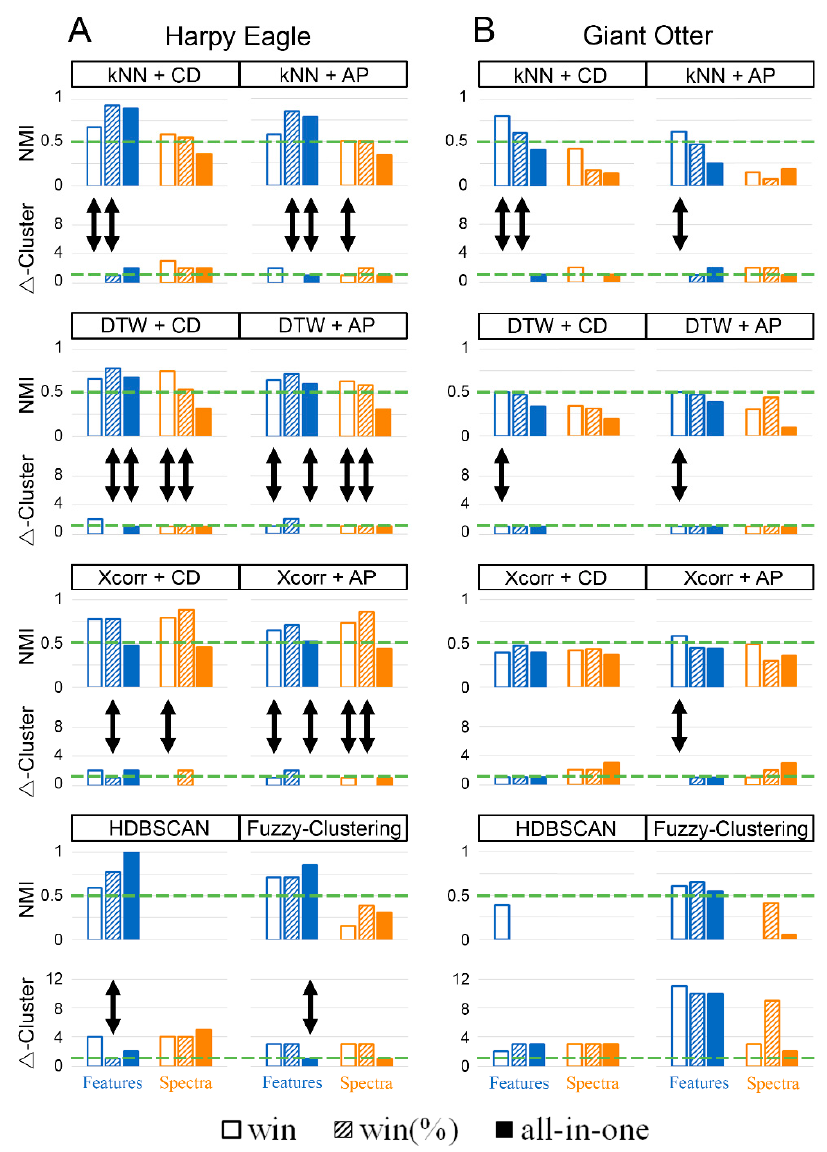
Figure 6. Results of the clustering methods obtained using the harpy eagle vocalizations ( A ) and the cohesion calls of the giant otters ( B ). The green dashed lines mark the threshold value that must be exceeded for NMI values (>0.5) and fallen below for Δ -Cluster values ( ≤ 1). The double arrows mark the cluster solutions that fulfill both the threshold value for NMI and the threshold value for Δ - Cluster.